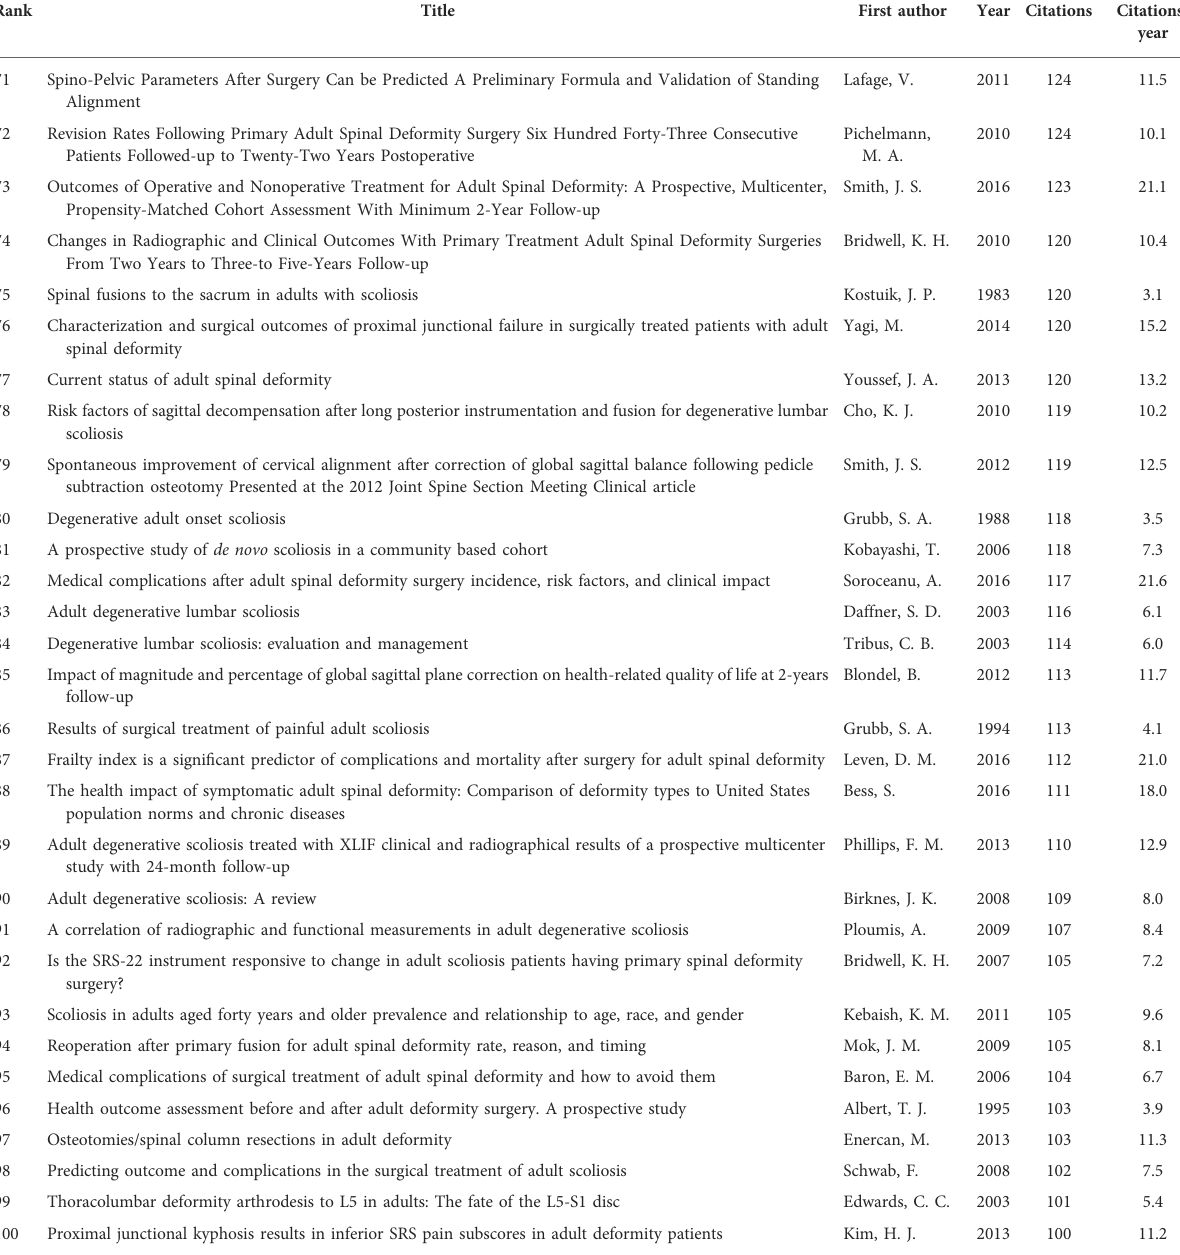
88 The health impact of symptomatic adult spinal deformity: Comparison of deformity types to United States population norms and chronic diseases Adult degenerative scoliosis treated with XLIF clinical and radiographical results of a prospective multicenter study with 24-month follow-up Adult degenerative scoliosis: A review A correlation of radiographic and functional measurements in adult degenerative